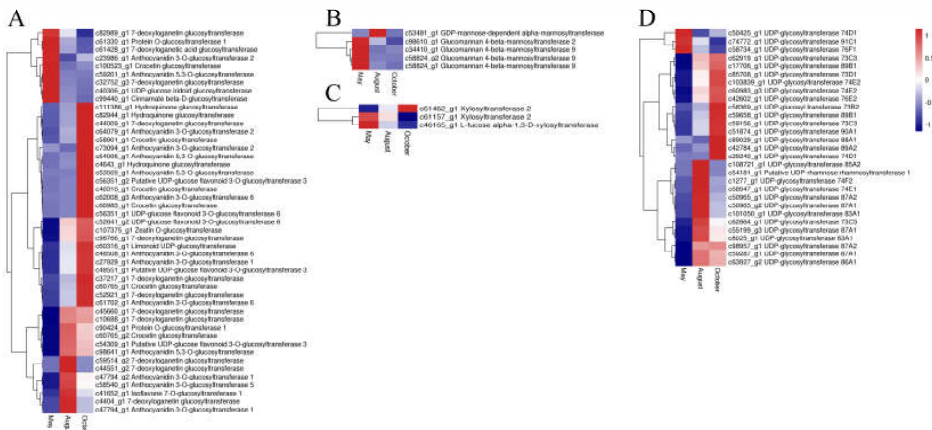
Figure 9. The expression level of glycosyltransferase DEGs including glucosyltransferases ( A ), mannosyltransferases ( B ), xylosyltransferases ( C ), UDP-glycosyltransferases ( D ). Blue and red colors represent different levels of gene expression and the color scales reflect a log 2 -transformed mean of FPKM values.